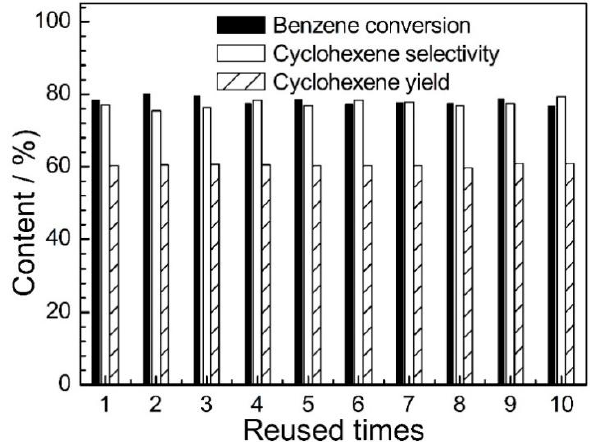
Figure 14. Catalytic activity towards benzene conversion, selectivity to cyclohexene and maximum yield of cyclohexene over Ru-4.7 catalyst for 10 runs of catalytic experiments ( v H2O = 280 mL, v benzene = 140 mL, T = 423 K, p H2 = 5.0 MPa).